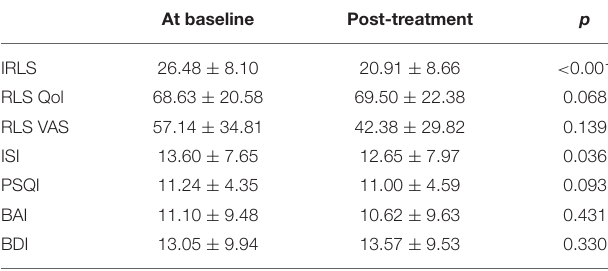
FIGURE 1 | Study flow chart. TABLE 1 | Mean ( ± SD) for the pre- and post-treatment RLS severity and sleep scale score. At baseline